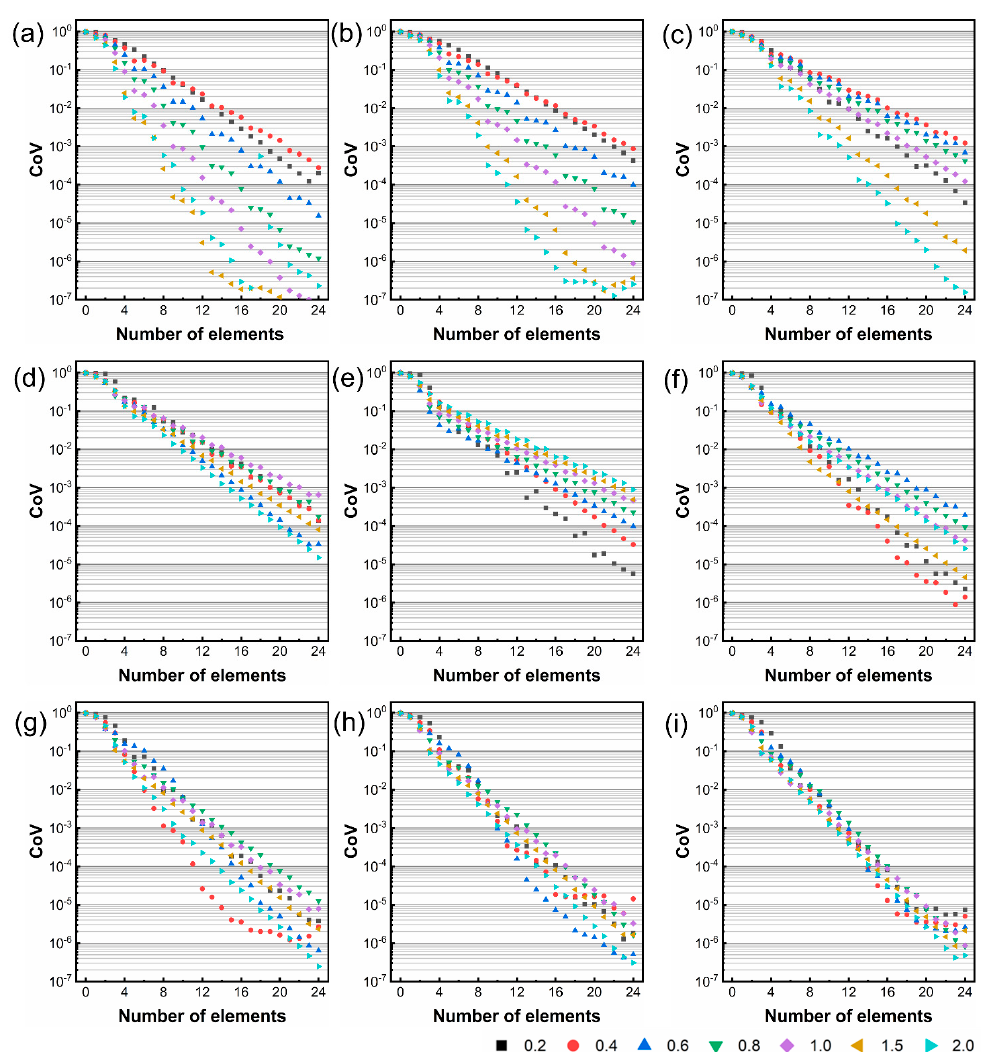
Figure 4. Effect of aspect ratio on CoV with different number of elements at ( a ) Re = 1; ( b ) Re = 5; ( c ) Re = 25; ( d ) Re = 50; ( e ) Re = 100; ( f ) Re = 200; ( g ) Re = 300; ( h ) Re = 400; ( i ) Re = 500.